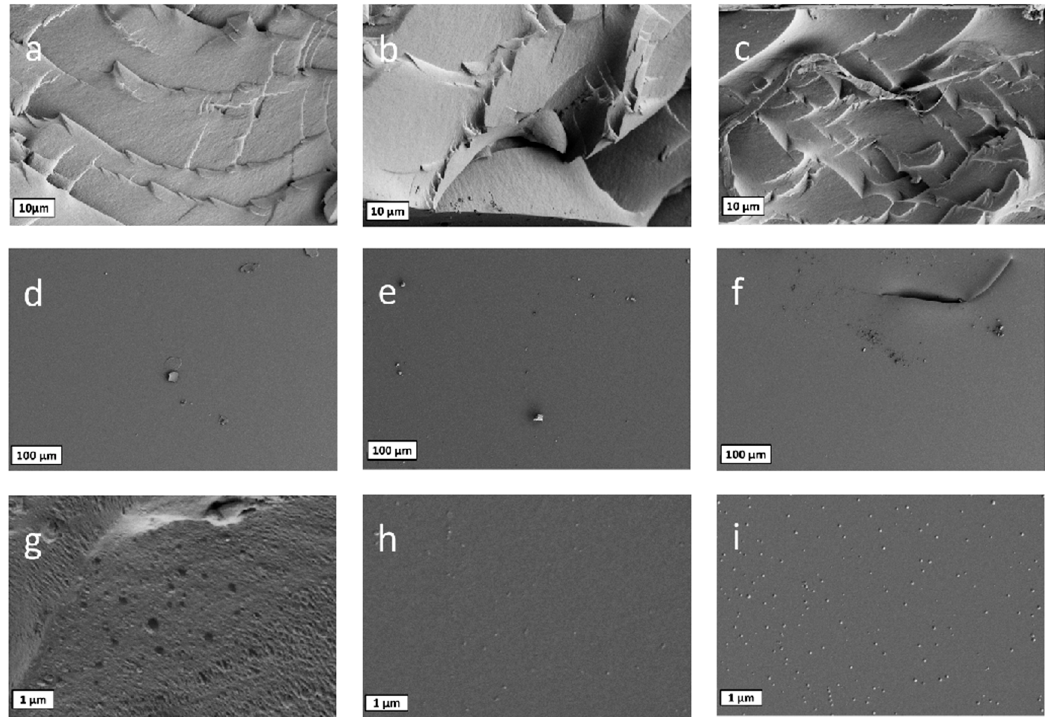
Figure 5. Scanning electron microscopy (SEM) images of cross sections ( a – c ) and surfaces ( d – i ) of the hydrogels materials with 0.05 wt % ( a , d , g ) 0.1 wt % ( b , e , h ) and 0.5 wt % ( c , f , i ) photoinitiator. White bars correspond to 10 μ m ( a – c ), 100 μ m ( d – f ), and 1 μ m ( g – i ).